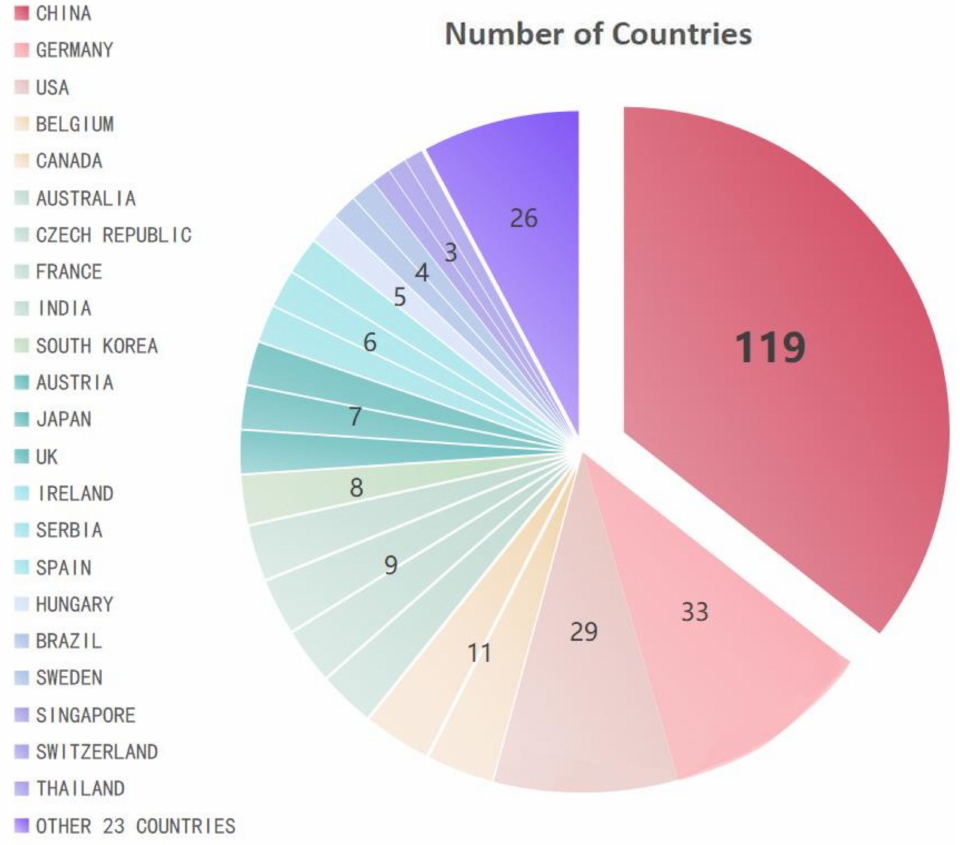
Figure 5. Number of published LCZ studies in each